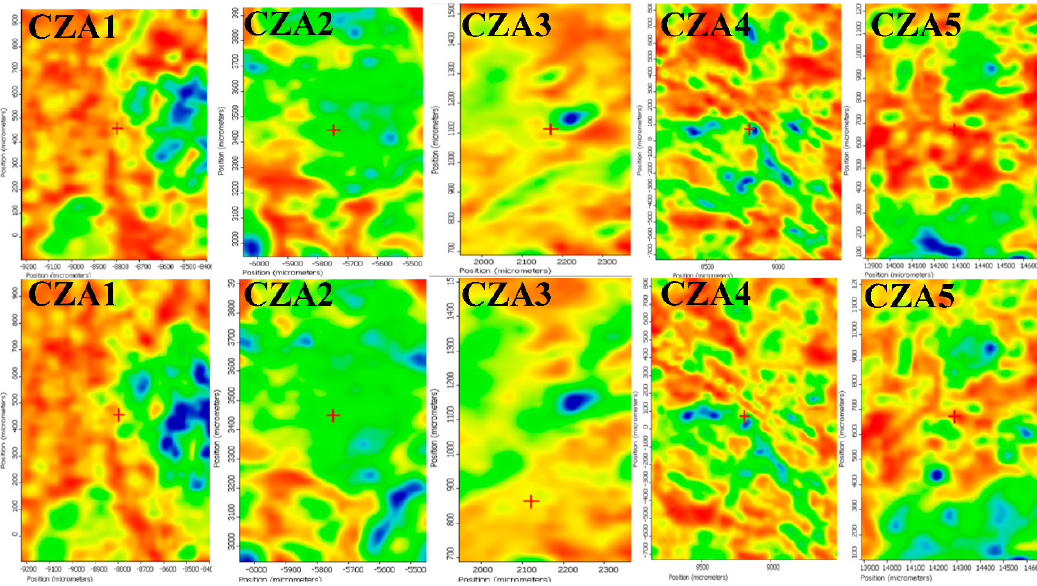
Figure 3. The FTIR maps for CZA1–CZA5 films at wavenumbers 3393 cm − 1 ( top row ) and 1643 cm − 1 ( bottom row ).